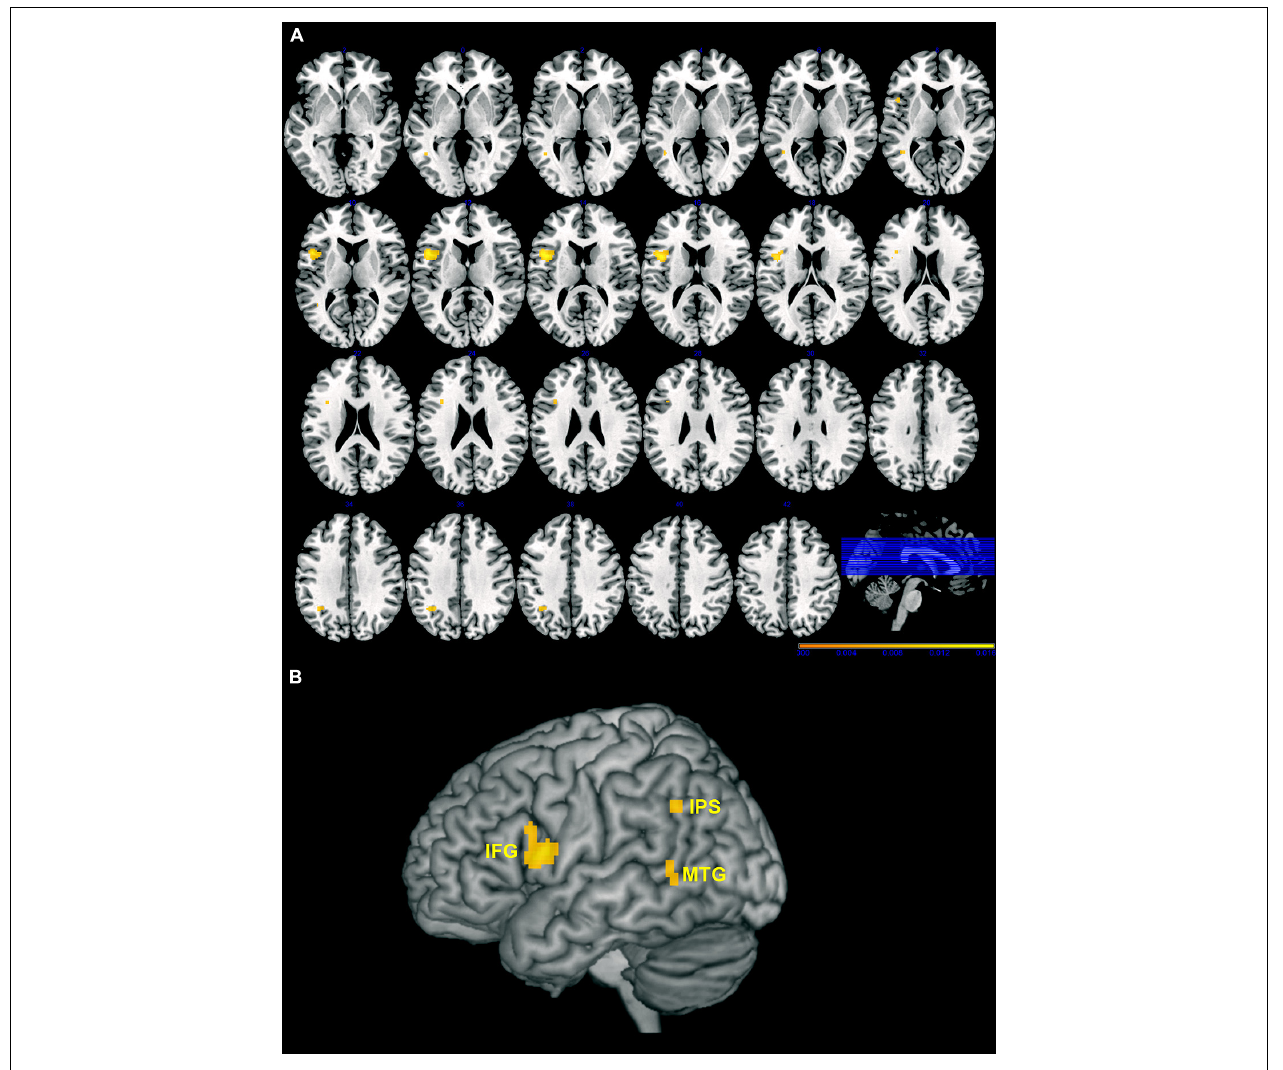
FIGURE 1 | Maps of the clusters with significant association between brain lesions and action perception, and understanding disorders overlaid on axial slices (A) or 3D rendering (B) of the Montreal Neurological Institute (MNI) template. Left hemisphere is on the left, and